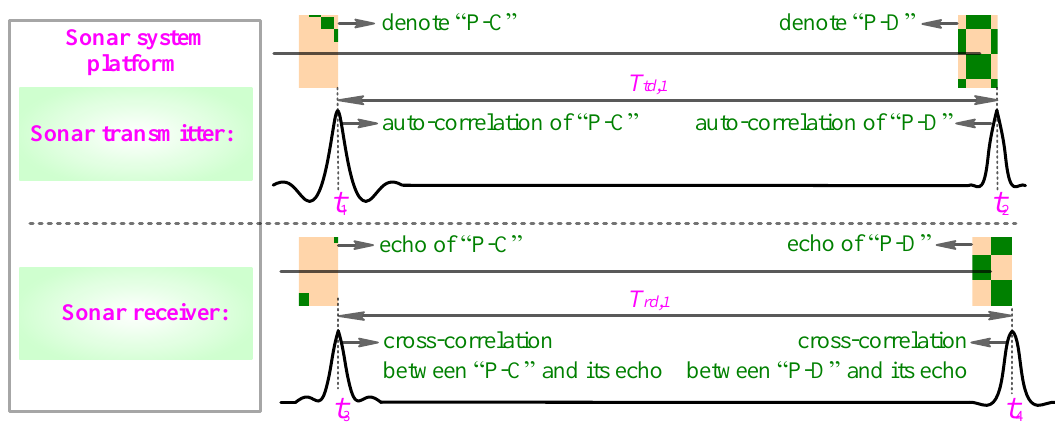
Figure 7. The measurement principle of the range and velocity of underwater targets.